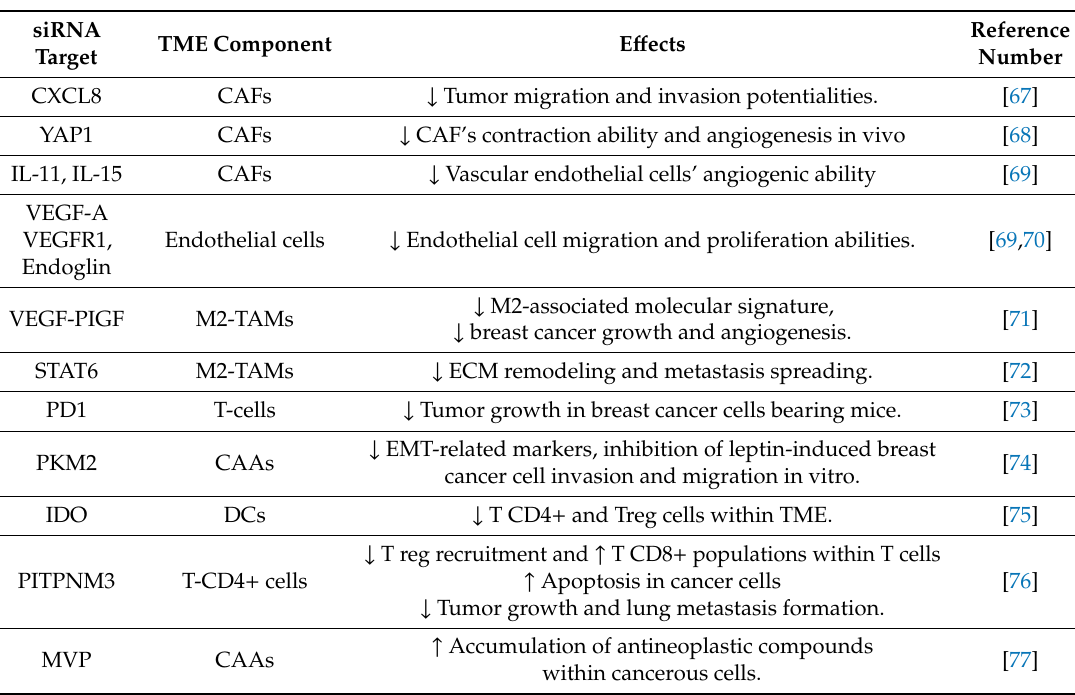
Table 1. siRNAs impairing the TME in breast